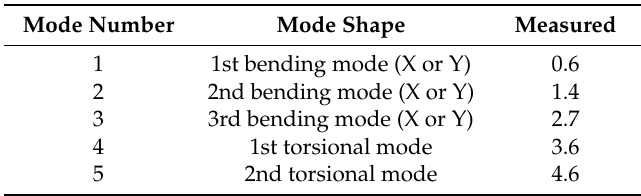
Table 3. Characteristic frequencies of met mast